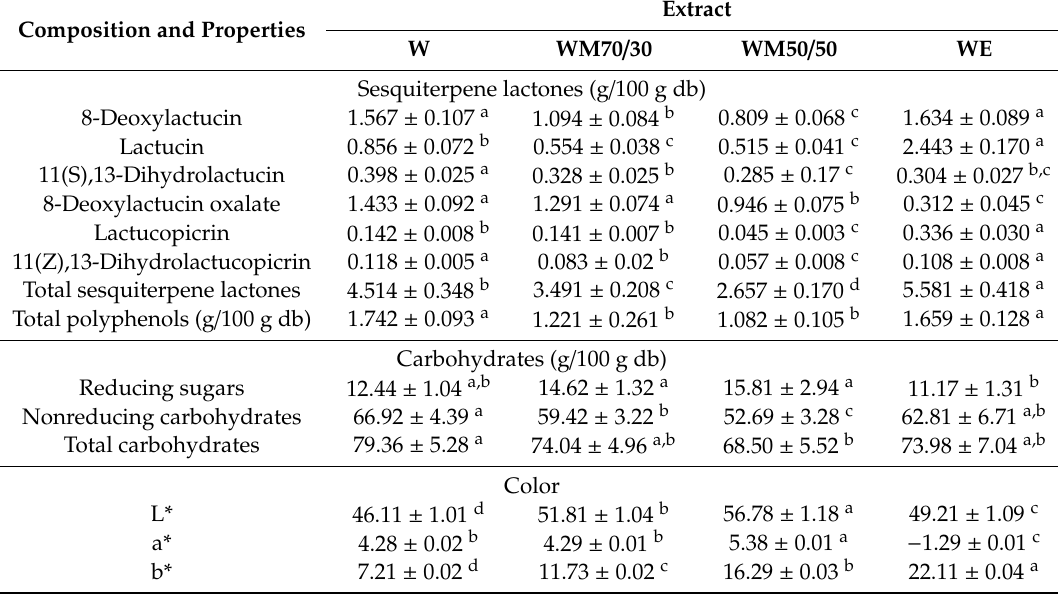
Table 3. Composition and properties of chicory root